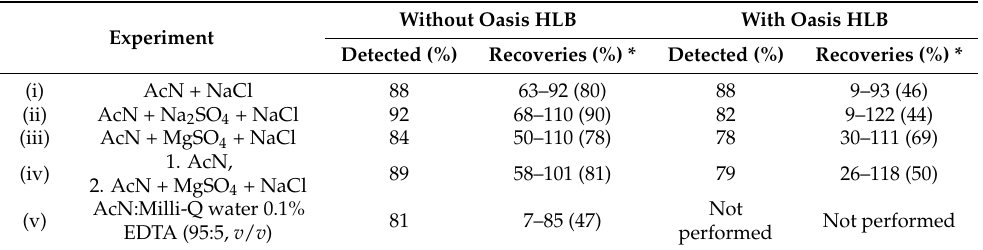
Table 1. Results of the experiments to optimize the addition of